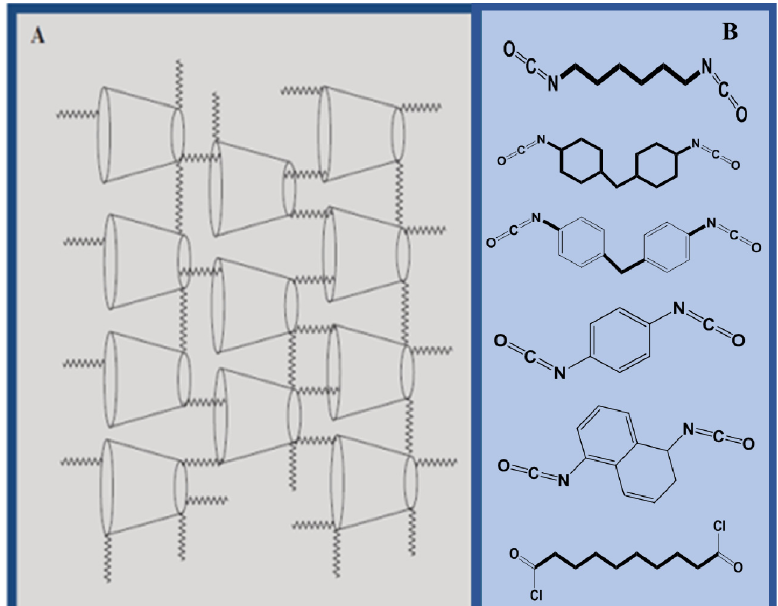
Figure 1. ( A ) A generalized 2-D framework structure of a β -cyclodextrin ( β -CD) cross-linked polymer; where the toroids represent the porogen ( β -CD) sites and the zigzag line segments are the bifunctional cross-linker scaffold of the framework. The polymer framework is shown as a semi-ordered material where the interior of the toroids are referred to as the “inclusion sites” and the other voids are the interstitial or “non-inclusion sites”; ( B ) Choice of different bifunctional cross-linker units (top-to-bottom; 1,6-hexamethylene diisocyanate (HDI), 4,4'-diicyclohexylmethane diisocyanate (CDI), 4,4'-diphenylmethane diisocyanate (MDI), 1,4-phenylene diisocyanate (PDI), 1,5-naphthalene diisocyanate (NDI), terephthaloyl chloride and sebacoyl chloride) gives rise to materials with variable physicochemical properties (redrawn from